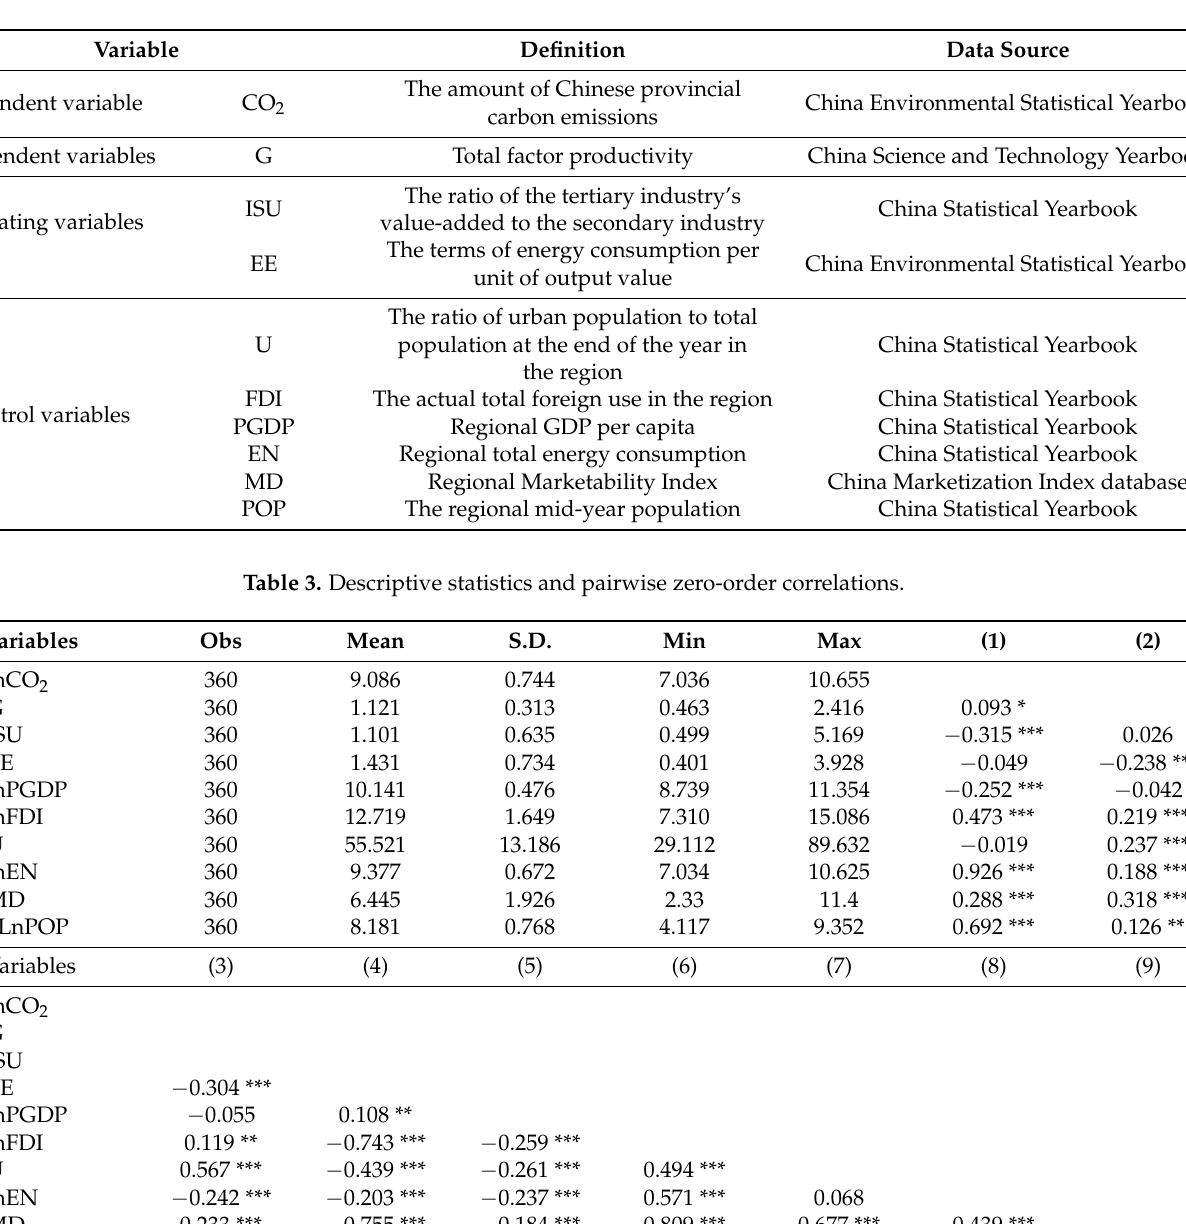
Table 2. Definition and data source of the variables.